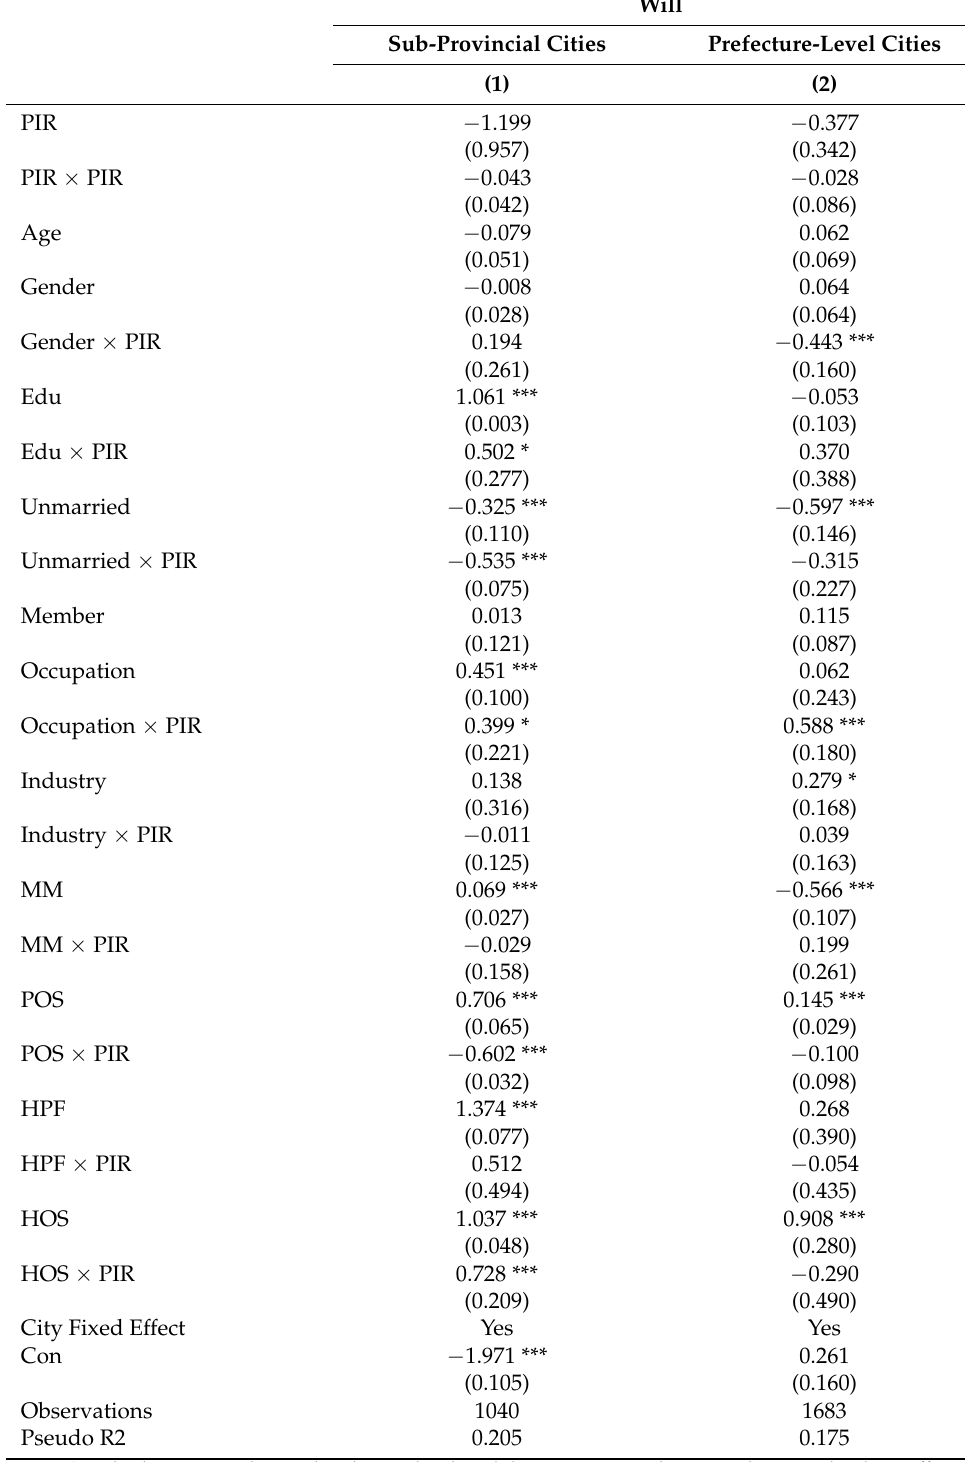
Table 3. Heterogeneity effects across cities in terms of HSYMs’ tolerance for housing